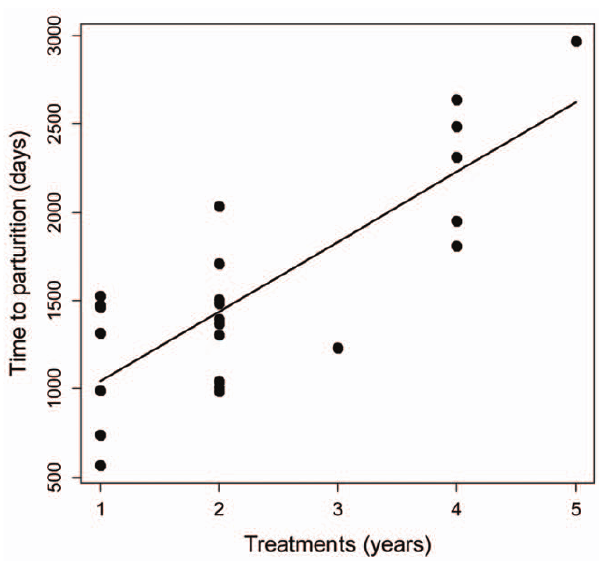
Figure 2. Time between final contraceptive inoculation and first parturition from feral horse ( Equuscaballus ) females. Births shown are from horses at Little Books Cliffs Wild Horse Range, CO, USA and Pryor Mountain Wild Horse Range, MT, USA as a function of consecutive annual porcine zona pellucida (PZP) inoculations, 2005–